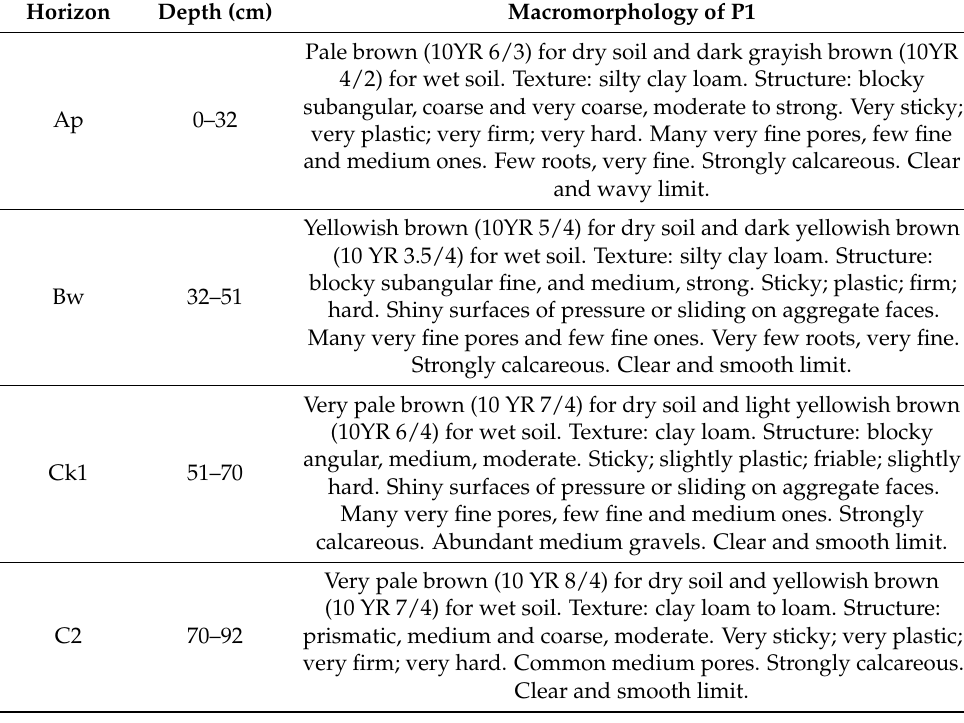
Table A2. Macromorphological description of profile 1 (P1).